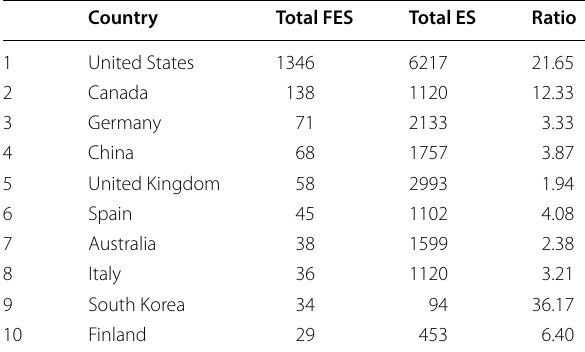
Table 2 The top 10 most productive countries in FES and ES papers (2005 to 2018) from ¥he Scopus